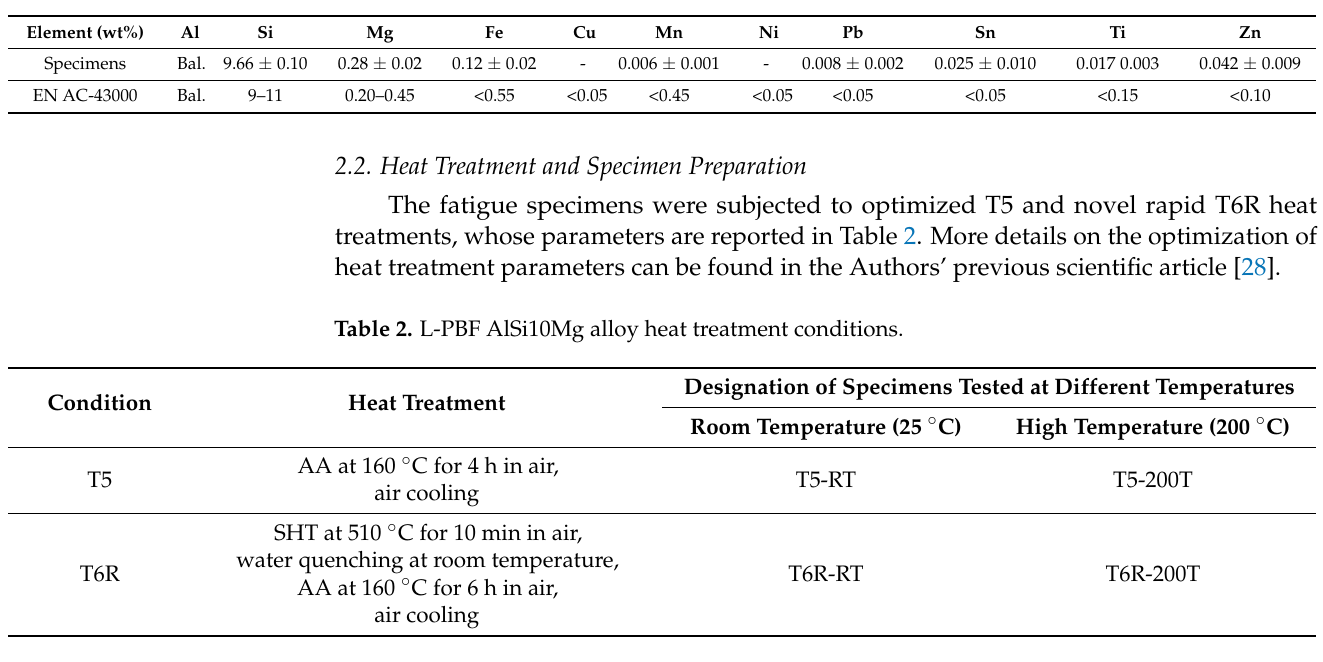
Table 1. Chemical compositions (wt%) include rod specimens (i), evaluated using GD-OES, and nominal composition of the AlSi10Mg alloy (ii), according to EN AC-43000.